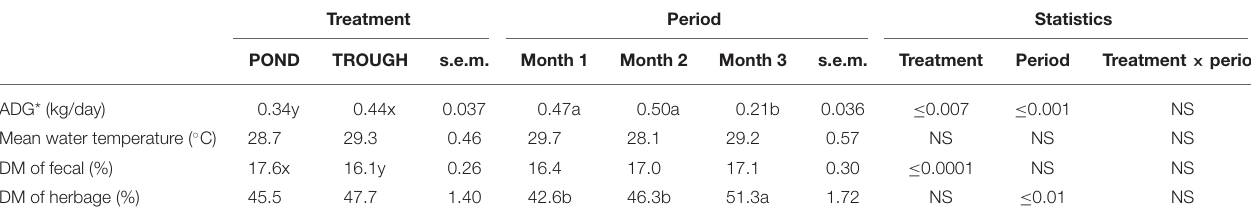
TABLE 1 | Effect of treatment and period on ADG, water temperature, and DM of fecal and herbage sampling (LSM ± SEM). Treatment